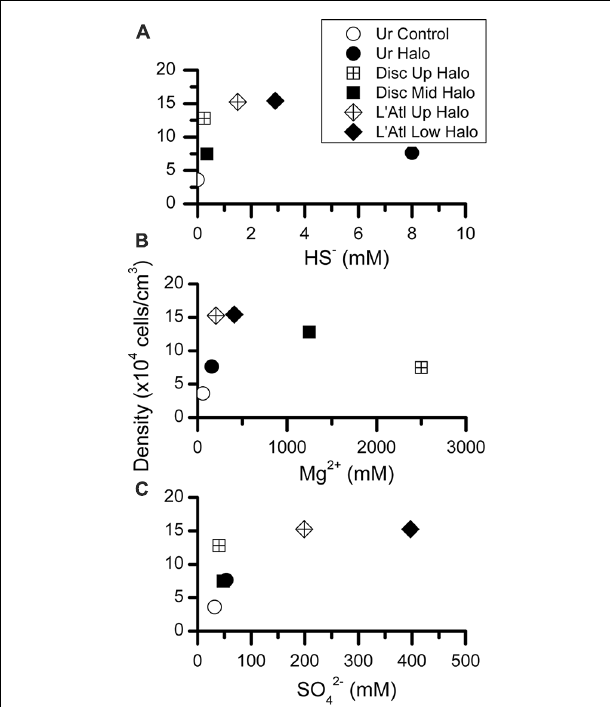
FIGURE 11 |Abundances of protists per cubic centimeter, calculated from microscopic counts, presented with respect to inferred chemical parameter in overlying waters. Chemical constituent data from van der Wielen etal.